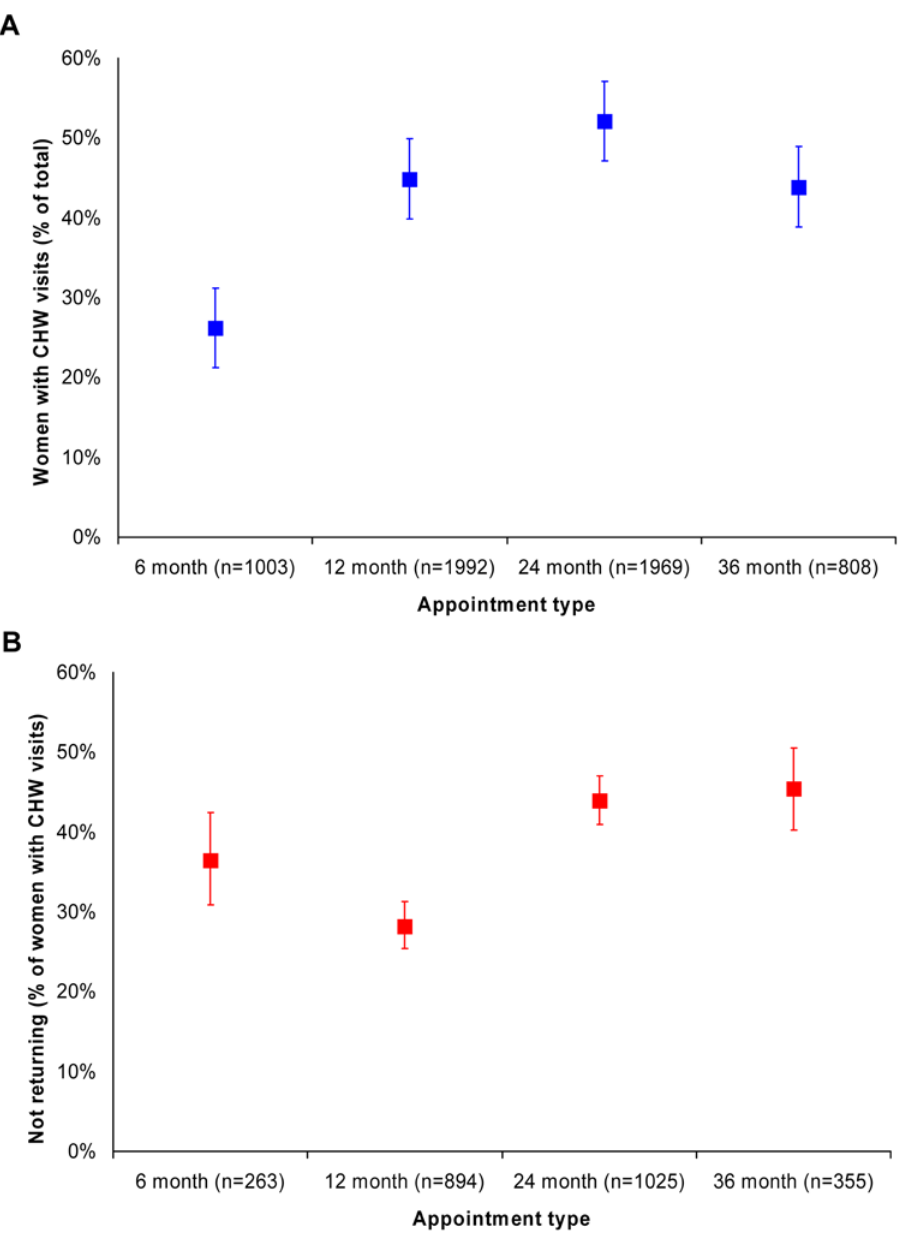
Figure 1. CHW visits and patient failure to return. Shown in the graph are the percentage and 95% confidence intervals of women who received 1 or more CHW visits by appointment type during 2003–4 (Panel A, blue squares); and the percentage and 95% confidence intervals of women receiving CHW visits who did not attend their scheduled appointments despite those visits (Panel B, red squares).